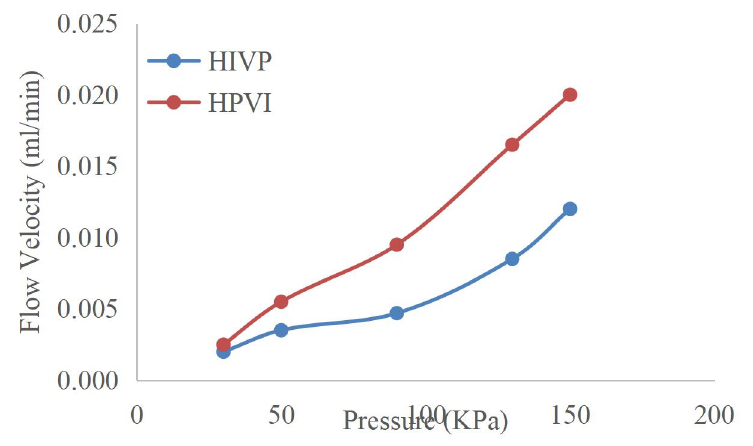
Figure 7—Flow velocity of HIVP and HPVI with